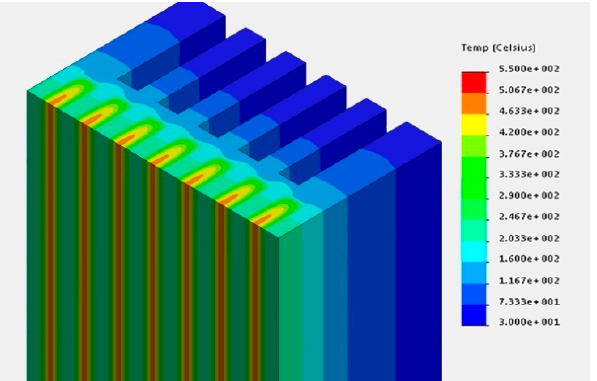
Figure 11. Grooved target thermal modeling.